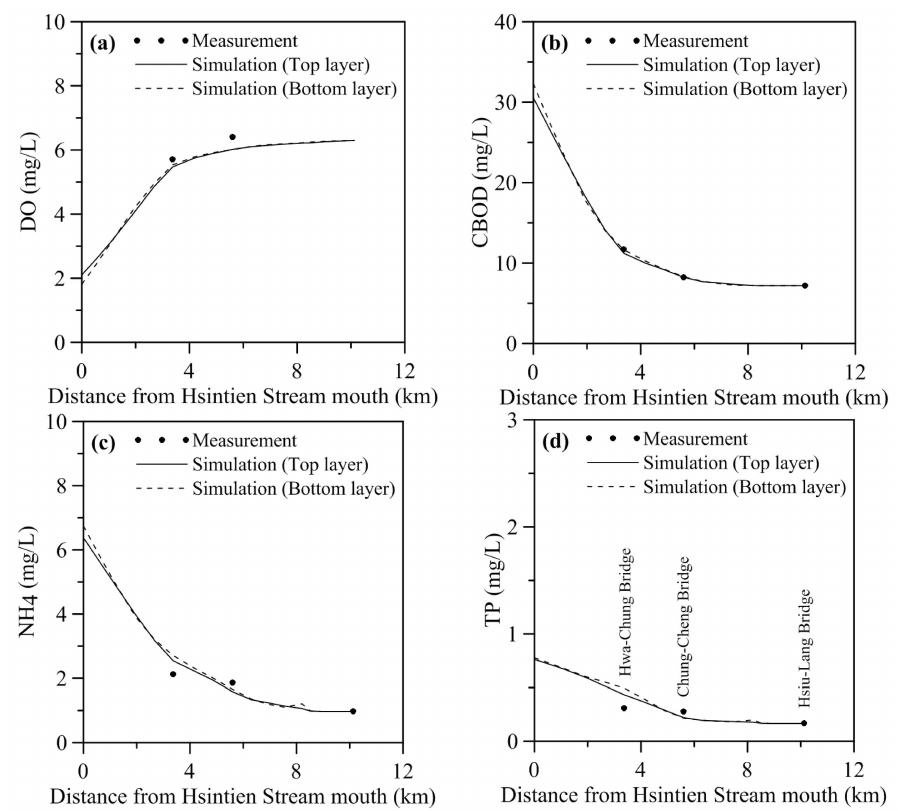
Figure 6. The comparison between the measured and simulated water quality distributions along the Hsintien Stream on 3 March 2011 ( a ) DO; ( b ) CBOD; ( c ) NH 4 ; and ( d ) TP.